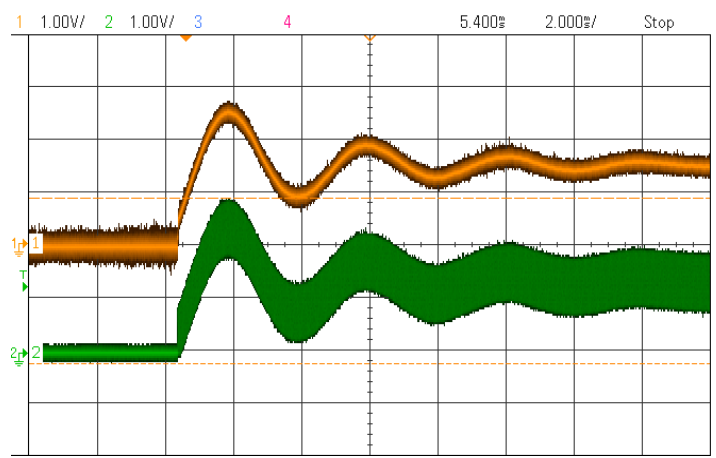
Figure 10. Comparison between a high-speed (lower wave) and low-speed (higher wave) DACs (Digital-to-Analog Converters). The transient process of a buck converter following the architecture of Figure 7b.